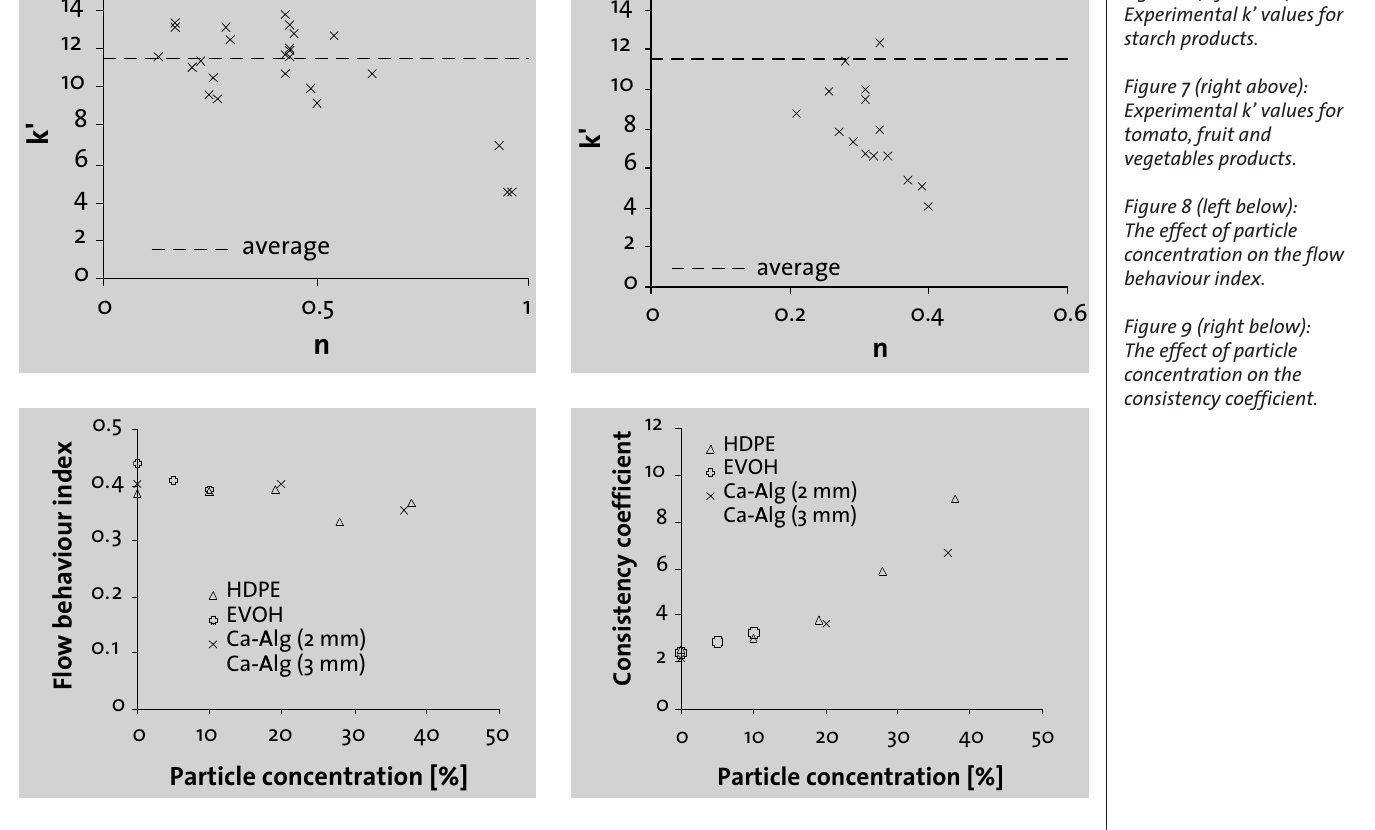
Figure 6 (left above): Experimental k’ values for starch products. Figure 7 (right above): Experimental k’ values for tomato, fruit and vegetables products. Figure 8 (left below): The effect of particle concentration on the flow behaviour index. Figure 9 (right below): The effect of particle concentration on the consistency